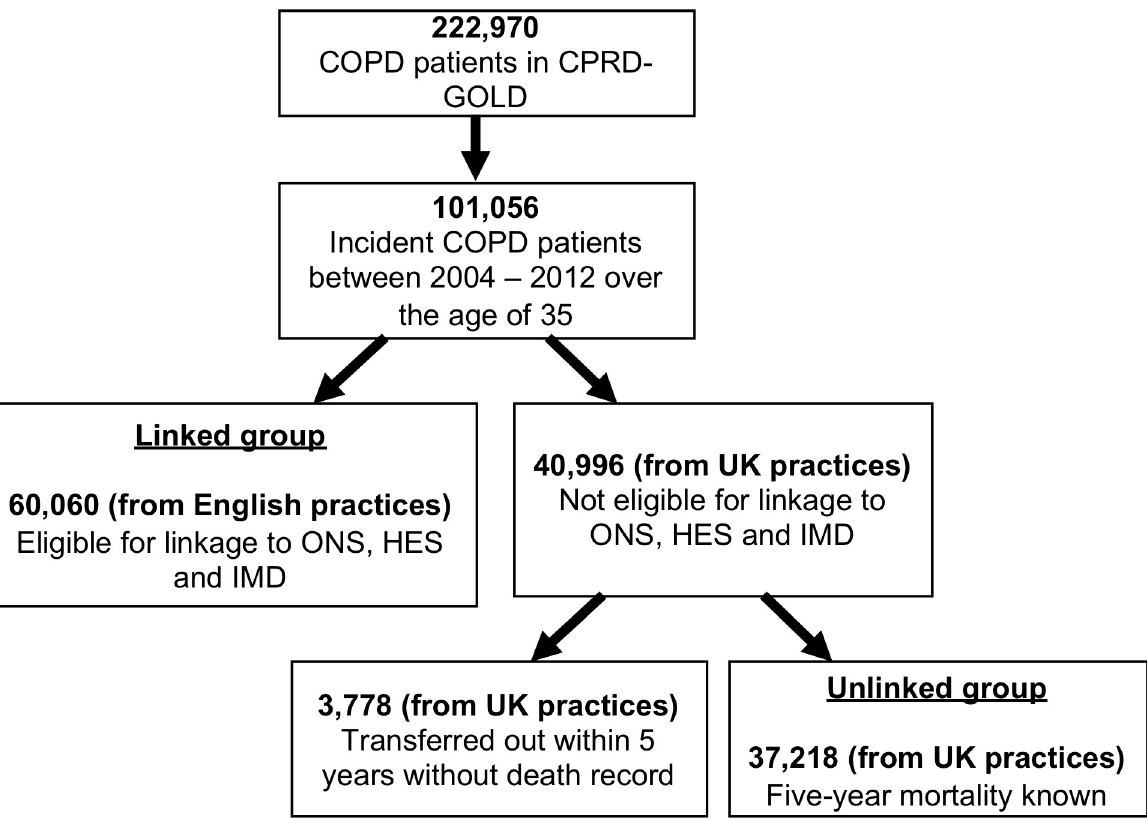
Fig 1. Flow diagram of included patients, highlighting linked and unlinked